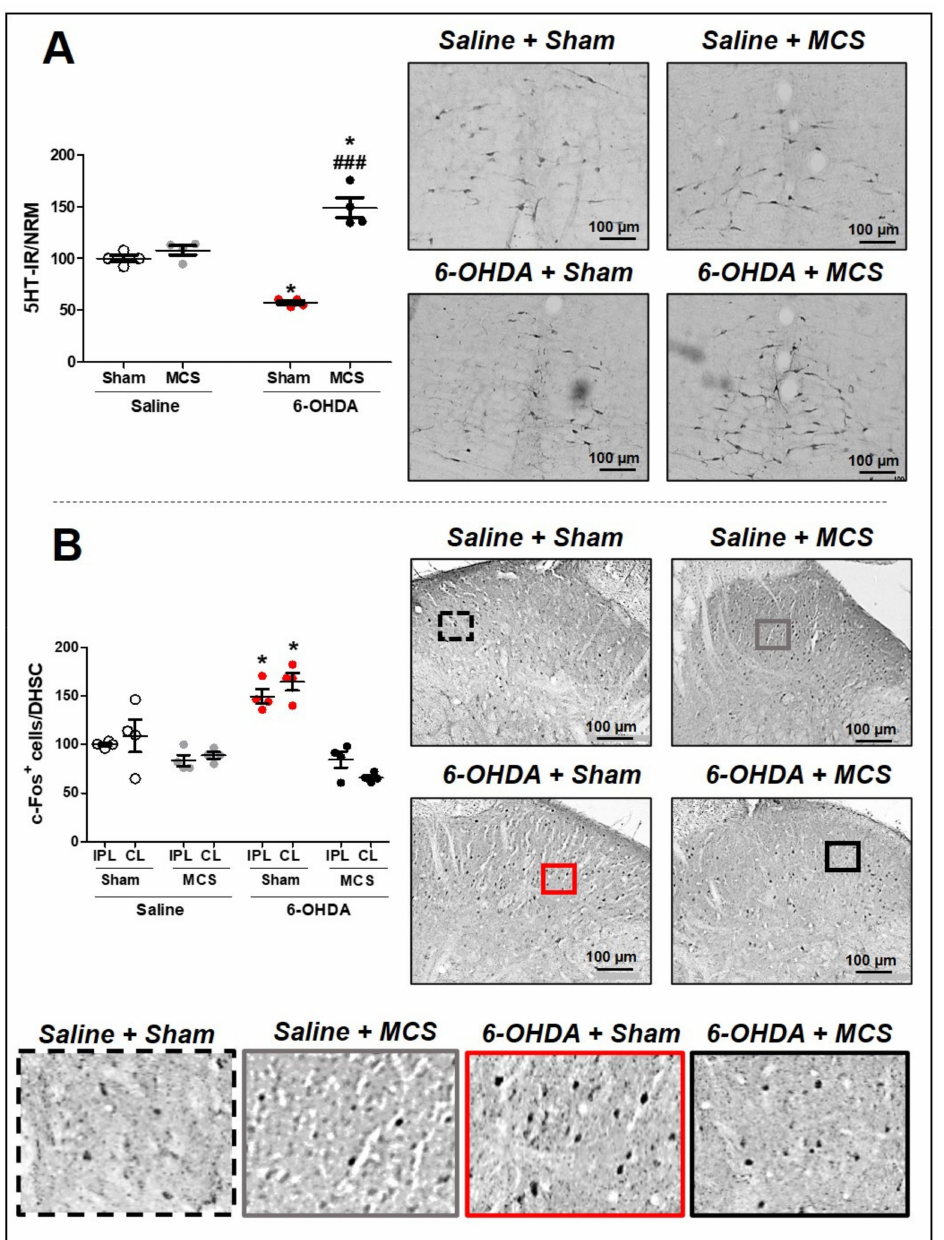
Figure 3. Serotonin immunoreactivity in the nucleus raphe magnus (NRM). Rats were evaluated in relation to immunore- activity (IR) for serotonin (5-HT) in the NRM ( A ). Values represent the mean + SEM normalizing saline + sham as 100%. * p < 0.05 when compared to the control group (saline + sham); ### p < 0.001 when compared to the 6-OHDA + sham group (1-w-ANOVA followed by Tukey post-hoc test). Photomicrographs of 5-HT-IR of rat saline + sham, rat saline + MCS, rat 6-OHDA + sham, and rat 6-OHDA + MCS. Pattern of activation in the dorsal horn of the spinal cord (DHSC). Rats were evaluated in relation of c-Fos-positive cells in the DHSC ( B ). Values represent the mean + SEM normalizing saline + sham as 100% (n = 4 per group). * p < 0.05 when compared to the control group (saline + sham) (1-w-ANOVA followed by Tukey post-hoc test). Photomicrographs of c-Fos-positive cells of rat saline + sham, rat saline + MCS, rat 6-OHDA + sham, and rat 6-OHDA + MCS. Enhanced photomicrographs for better labeling visualization. 6-OHDA, 6-hydroxydopamine; MCS, motor cortex stimulation; IPL, ipsilateral to the lesion; CL, contralateral to the